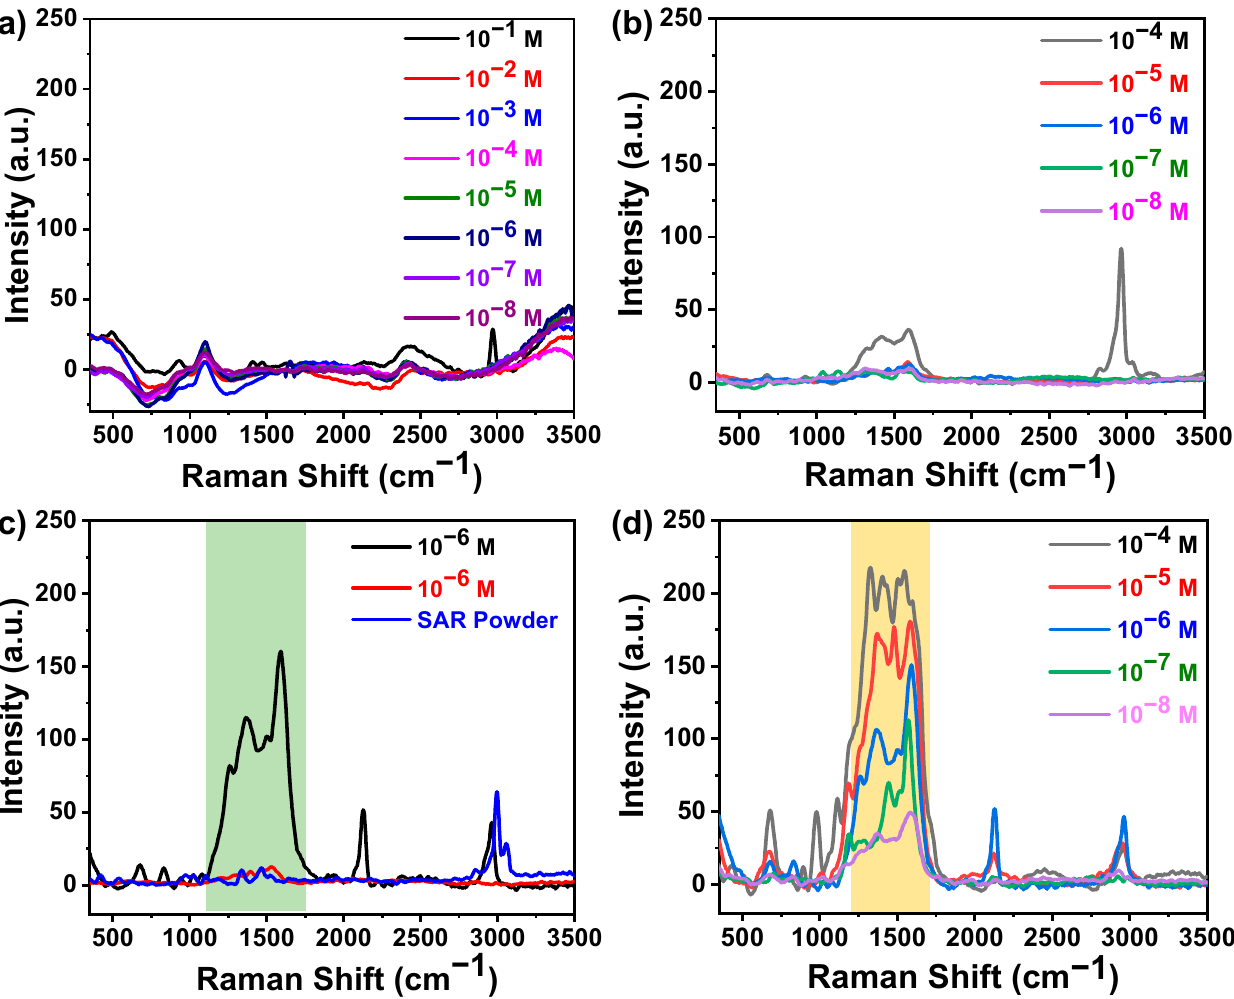
Figure 4. ( a ) Recorded Raman spectra of sarcosine at different concentrations; ( b ) recorded Raman spectra for different concentrations of sarcosine deposited over bare Ag as a substrate, indicating that no significant SERS enhancement was observed; ( c ) a comparative plot of obtained Raman signals of pure bulk sarcosine powder (blue line), 10 − 6 M concentration of sarcosine over bare Ag as a SERS substrate (red line), and silica modified SERS substrate (black line); ( d ) recorded Raman spectra for different concentrations of sarcosine over the SiO 2 decorated silver nano-islands as a SERS substrate, indicating the significant enhancement of Raman signals even at very low concentration of sarcosine ~10 − 8 M.